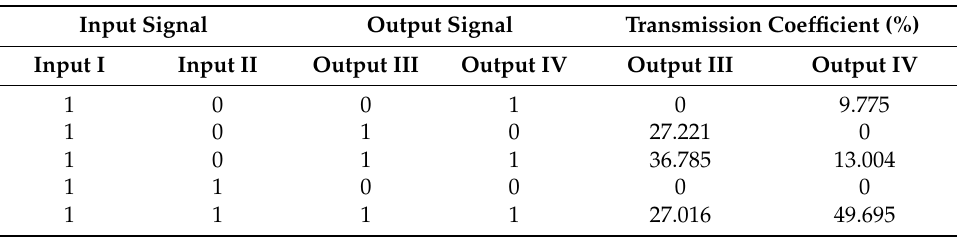
Table 2. Transmission coefficients of the X-branch switch at different logical states.